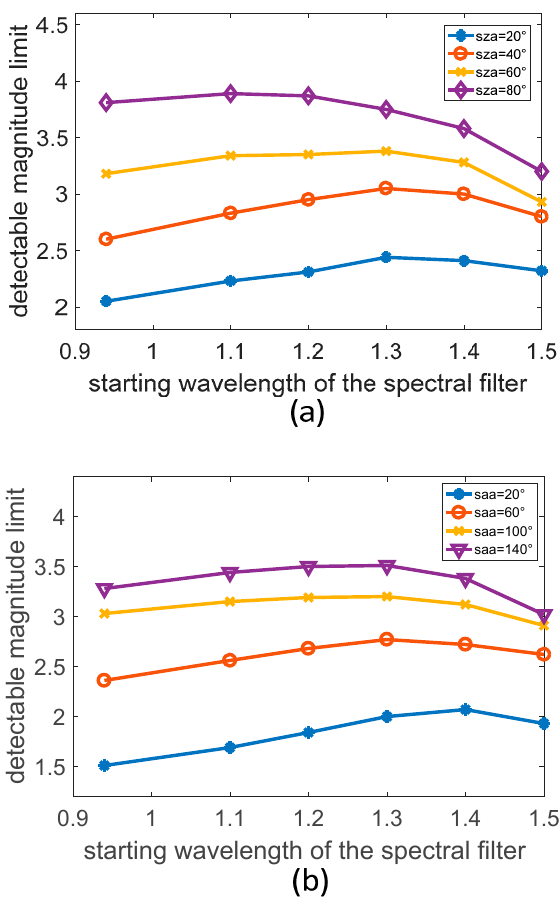
Figure 8. Detectable magnitude limit corresponding to different filters with different observation angles at 20 km. ( a ) SZA changes with VZA of 0° and SAA of 180°. ( b ) SAA changes with VZA of 40° and SZA of 45°.